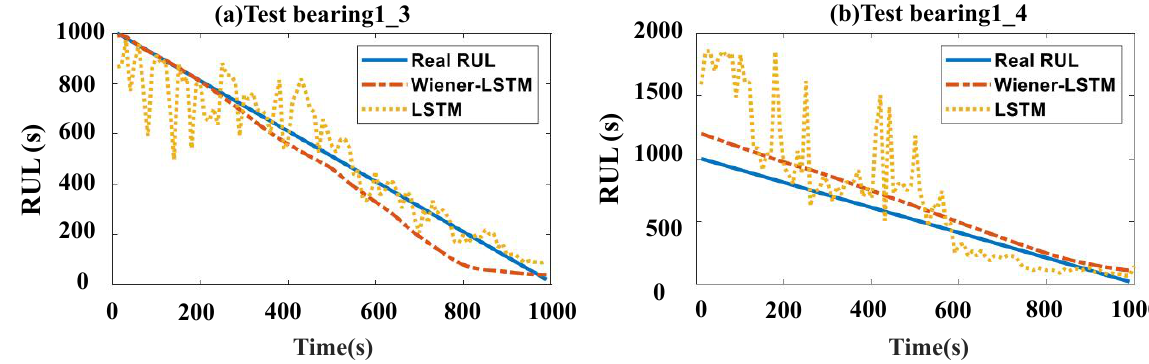
Figure 11. The predicted RUL by the Wiener–LSTM model and LSTM model. ( a ) The predicted results on test bearing1_3. ( b ) The predicted results on test bearing1_4. The blue line is the real RUL from 1000–0 s. The yellow line is the predicted result by the normal LSTM model using the MSE loss function. The orange line is the predicted result by the Wiener–LSTM model using the proposed loss